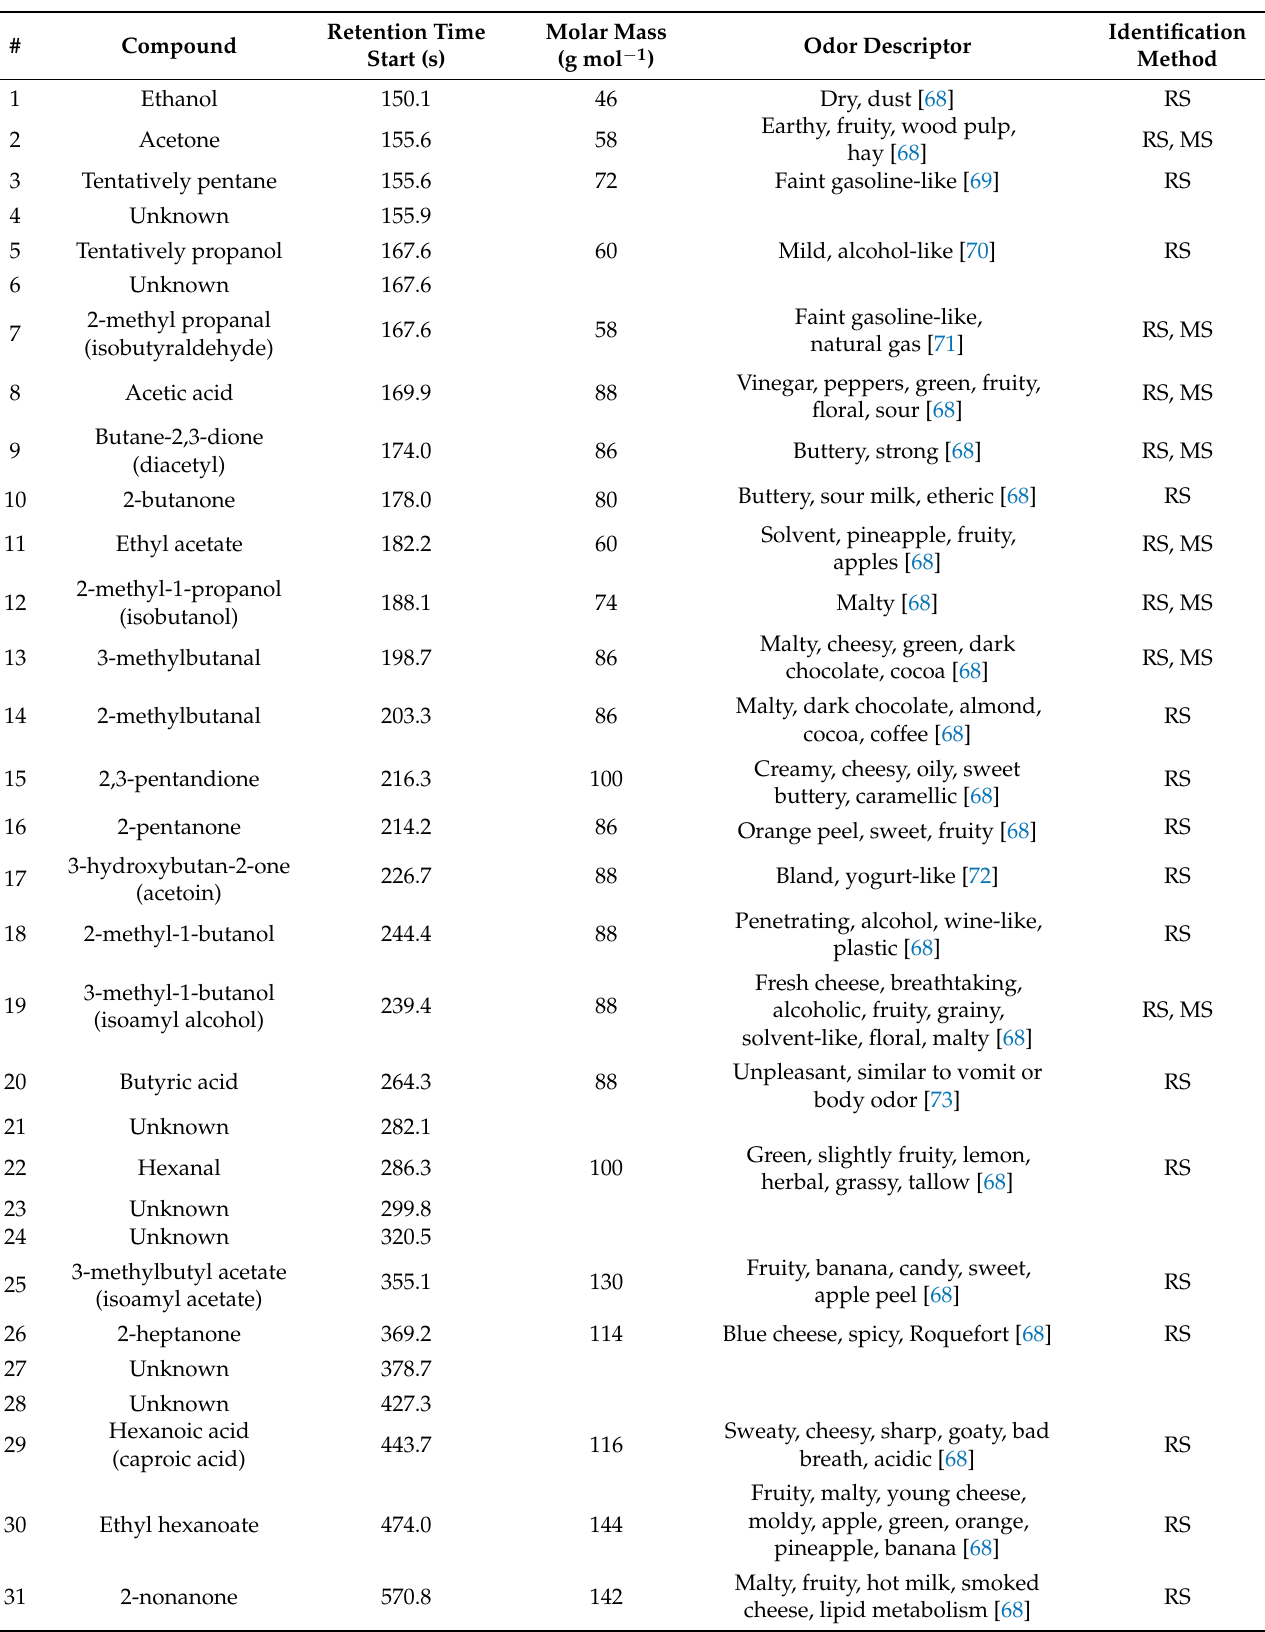
Table 3. Volatile organic compounds (VOCs) detected in kefir by gas chromatography–ion